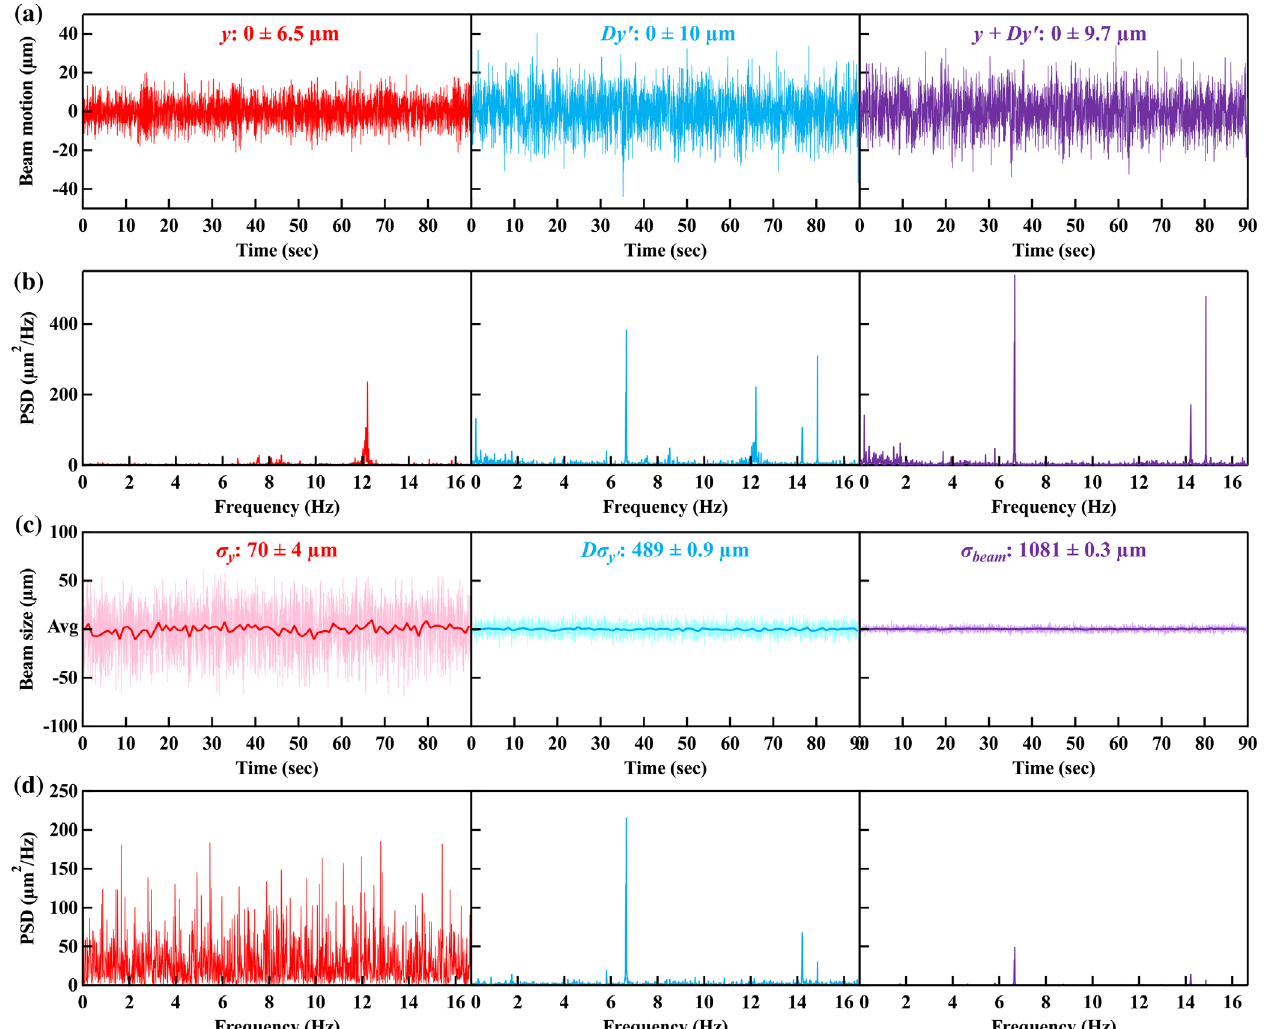
FIG. 3. (a) Beam motions including y (left), Dy 0 (middle), and y þ Dy 0 (right) as a function of the time. (b) PSD functions of the three curves in (a). (c) Time evolution of σ y (left), D σ y 0 (middle), and σ (right). The light colored and dark colored curves are for a beam sampling time of 0.03 and 0.9 s, respectively. (d) PSD functions of the light colored curves in